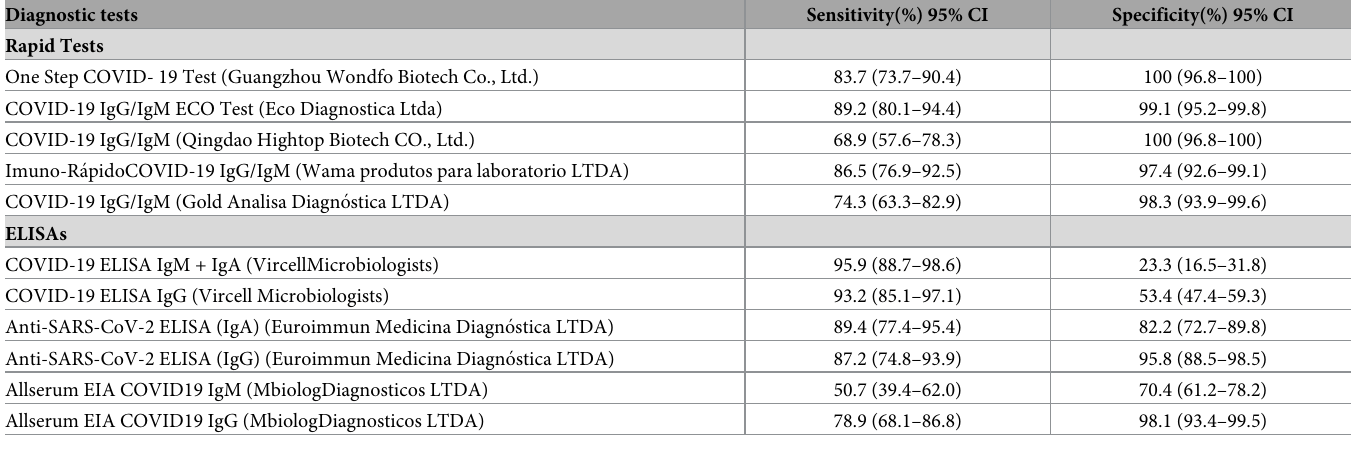
Table 1. Performance of the evaluated COVID-19 diagnostic tests performed after 14 days from onset of